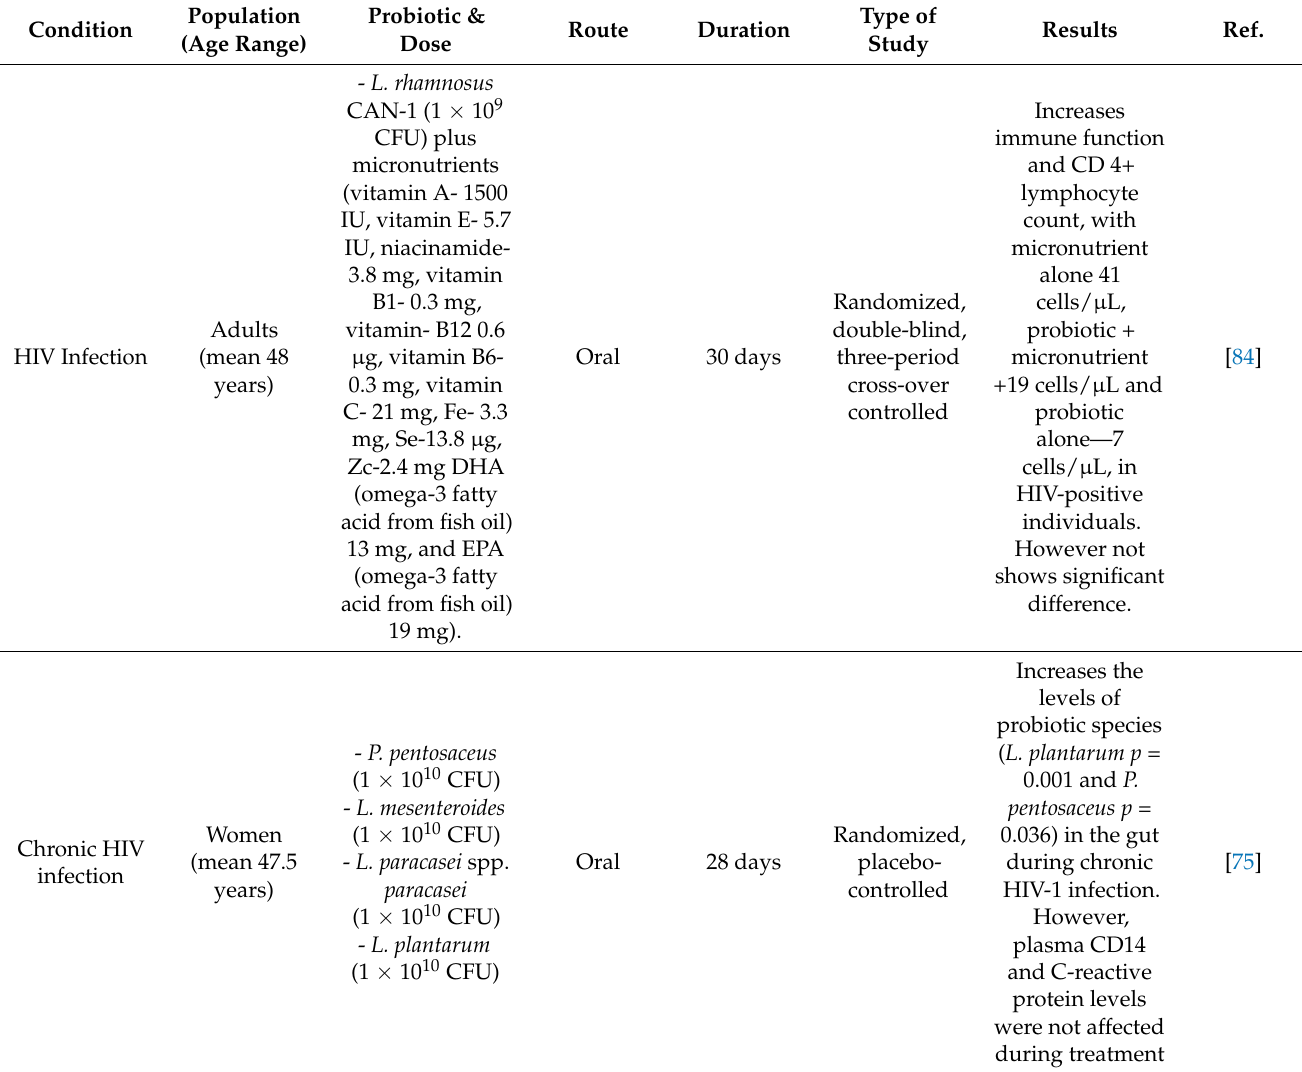
Table 2. Probiotics used in clinical trials to treat human immunodeficiency virus (HIV) infections.